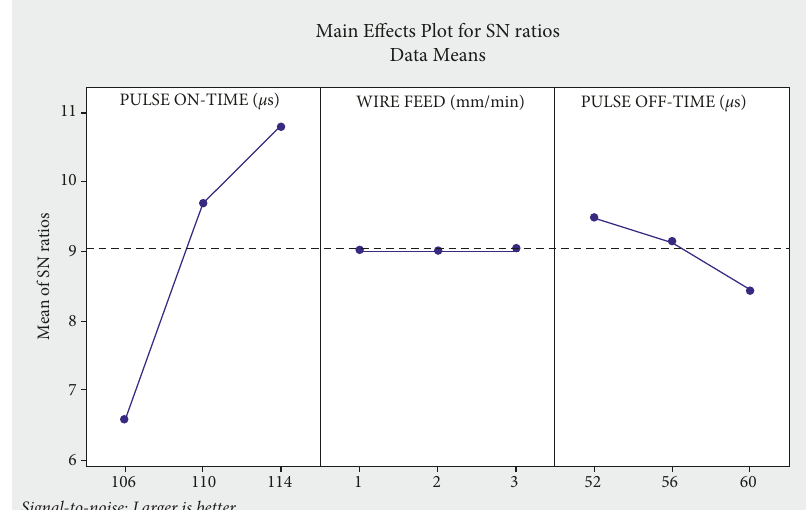
Main Effects Plot for SN ratios Data Means